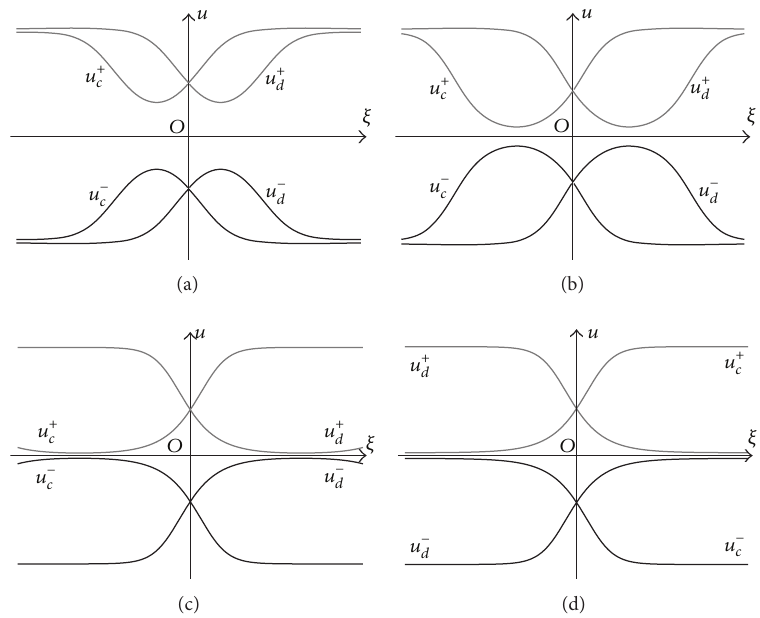
Figure 5: Four low-kink waves are bifurcated from four antisymmetric solitary waves. The varying process for the figures of 𝑢 ± 𝑐 and 𝑢 ± 𝑑 when | , (𝑎,𝑏) ∈ 𝐴 𝑏 → −(5𝑎 2 /48𝑐)−0 , where 𝜂 = 10 , 𝛿 = 𝛾 = 𝑐 = 𝑎 = 1 , and (a) 𝑏 = −(5𝑎 2 /48𝑐)−10 −2 , (b) 𝑏 = −(5𝑎 2 /48𝑐)−10 −3 , 𝜂 > 0 , 𝜂 ̸=|𝜇 0 3 , and (c) 𝑏 = −(5𝑎 2 /48𝑐) − 10 −5 , and (d) 𝑏 = −(5𝑎 2 /48𝑐) − 10 −7